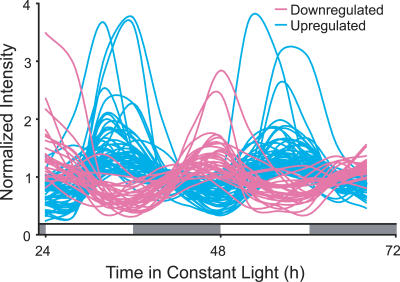
Circadian Regulation of RWR GenesThese data are comprised of circadian-regulated RWR genes. Upregulated RWR genes (blue) peak at dusk while downregulated RWR genes (pink) peak at dawn. Plants were entrained in light/dark cycles for 7 d and then released into constant light. Samples were collected every 4 h after plants were moved to constant light.